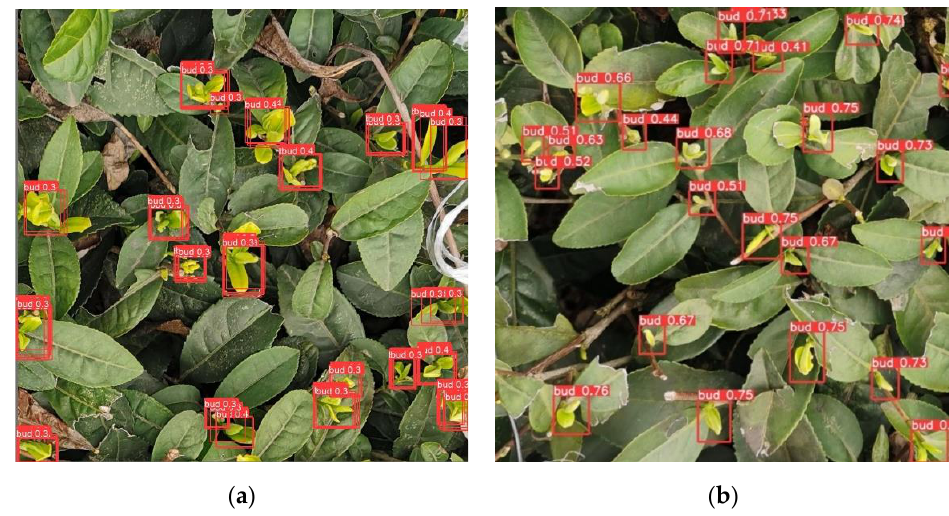
Figure 15. Tea trees germination detection results: ( a ) tea trees germination detection results based on YOLOv5m; ( b ) tea trees germination detection results based on improved YOLOv5.